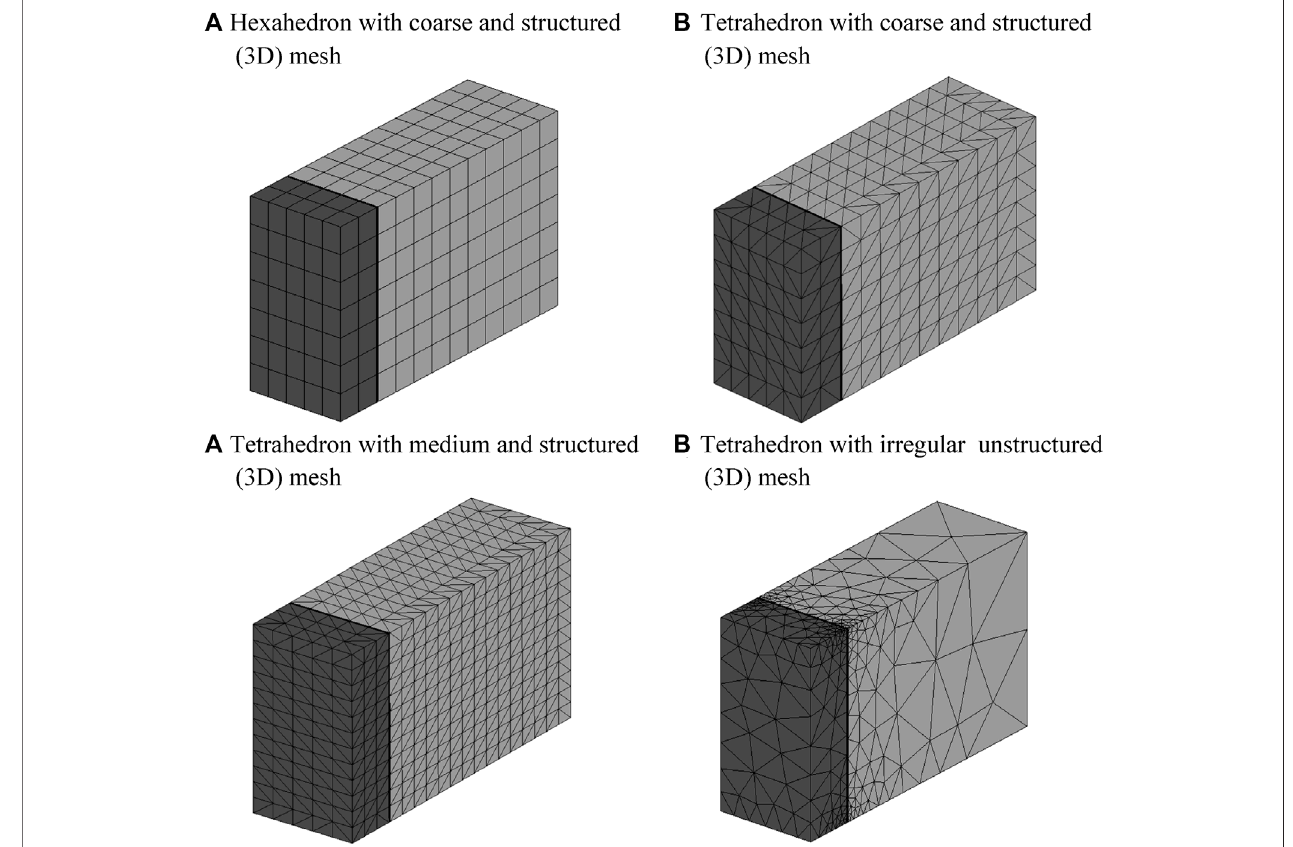
FIGURE15| Twodifferent fi niteelementmeshesforthesamesoil – structureinteraction3DexampleusingprogramCODE_BRIGHT: (A) coarsestructured(trilinear hexahedron elements) mesh and (B) optimized unstructured (linear tetrahedron elements) mesh with the same interface virtual thickness ti = 0.018 m.